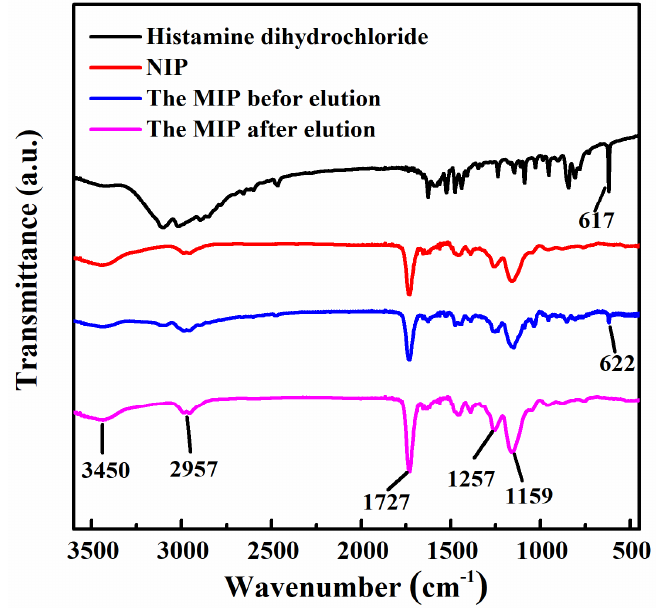
Figure 1. FT–IR spectra of histamine dihydrochloride, NIP, the MIP before elution and after histamine elution.